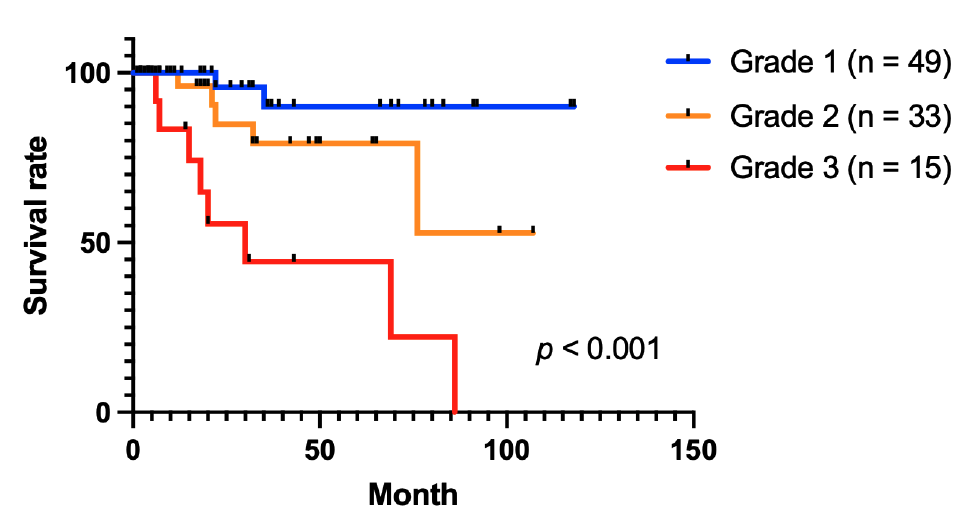
Figure 4. Log-rank (Mantel–Cox) test of patients with coal workers’ pneumoconiosis according to the three grading systems of pulmonary exfoliative